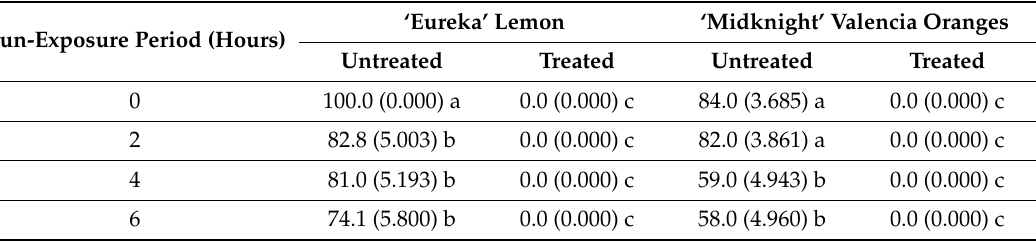
Table 2. Mean percentage (standard error) of CBS lesions which released pycnidiospores on untreated ‘Eureka’ lemon and ‘Midknight’ Valencia orange fruit after exposure of lesions to sunlight from 0 to 6 h. Sun-Exposure Period